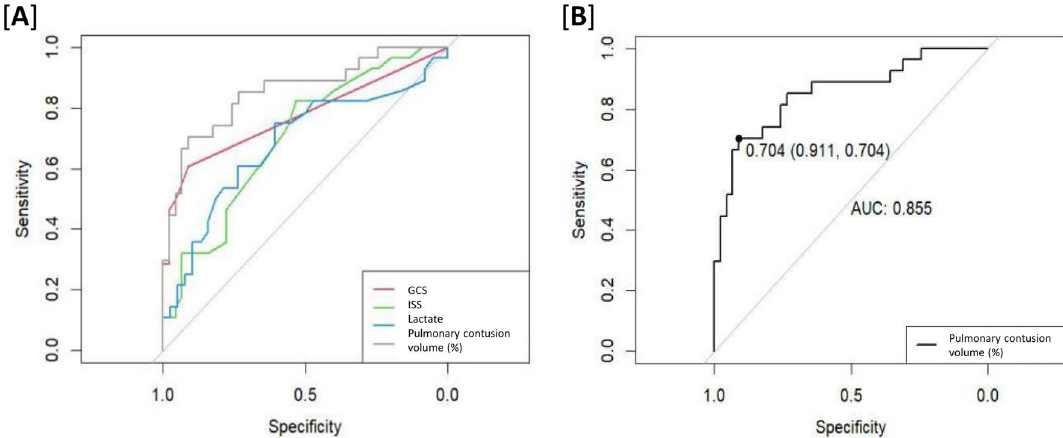
Figure 4. Receiver operating characteristic curve for the prediction of pneumonia.